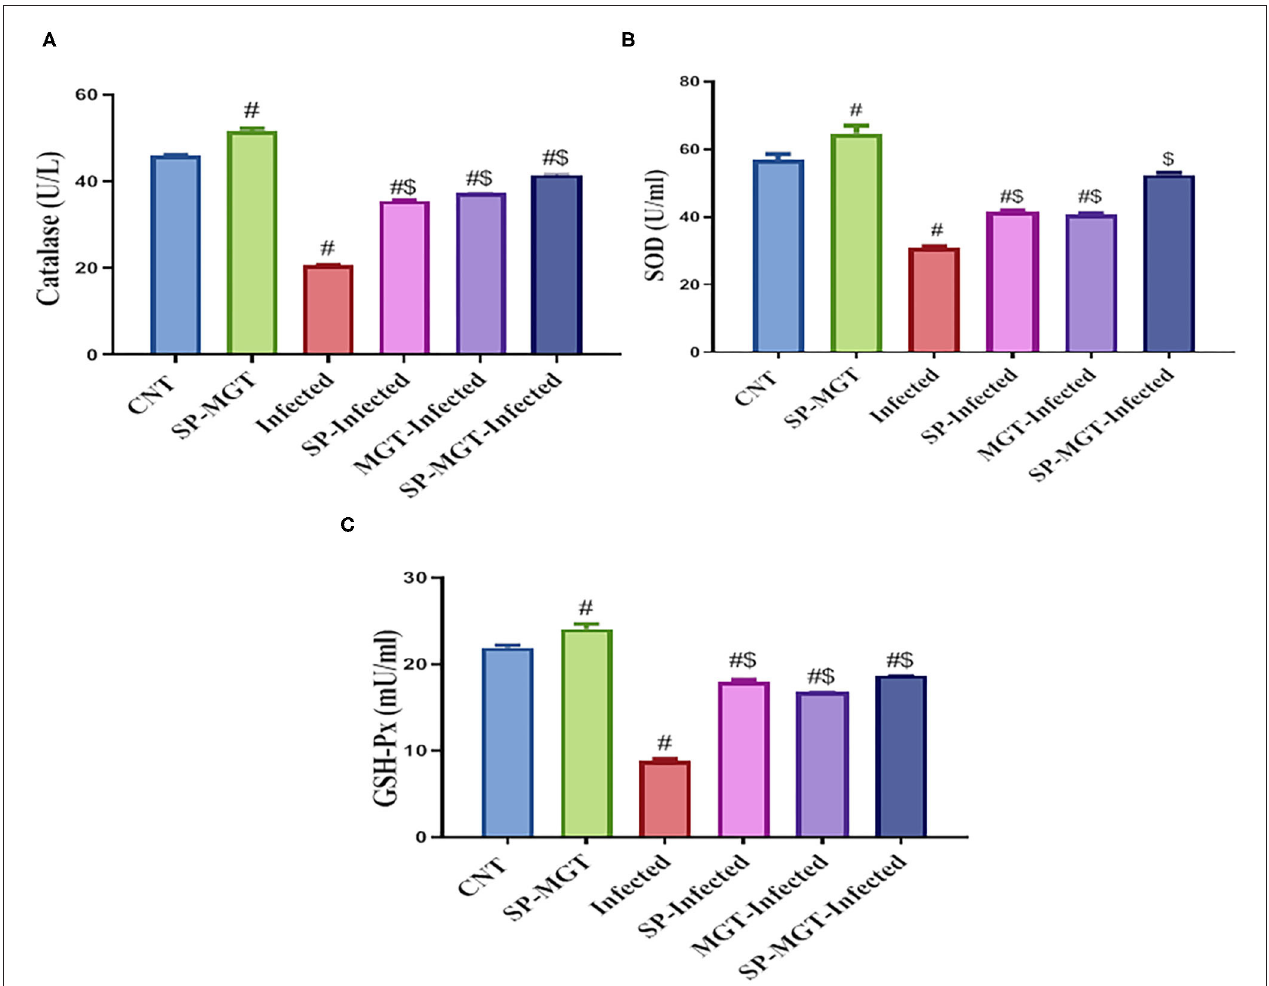
FIGURE 3 | Catalase (CAT; A ), superoxide dismutase (SOD; B ), and glutathione peroxidase (GSH-Px; C ) activities in serum of mice in response to co-treatment with Spirulina platensis and/or matcha green tea in S. mansoni infected mice. Data were displayed as mean ± SD ( n = 10/group). # or $ refers to the statistical significance at P < 0.05 against control and S. mansoni (infected) groups,